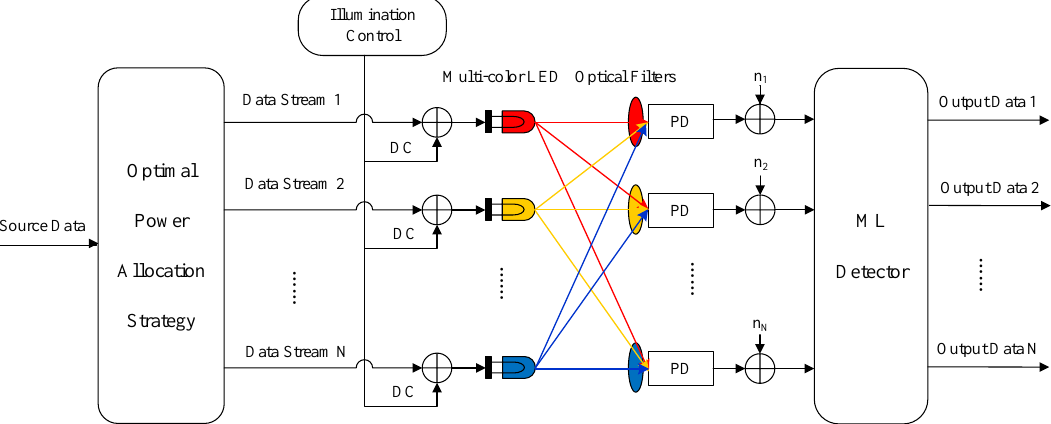
Figure 1. CMIMO model for the multi-color light-emitting diodes (LED) based visible light communication (VLC)